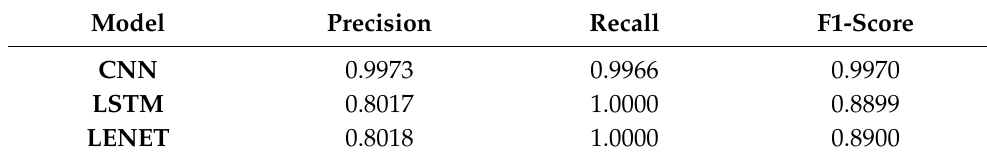
Table 4. The performance of the base learner on the dataset.